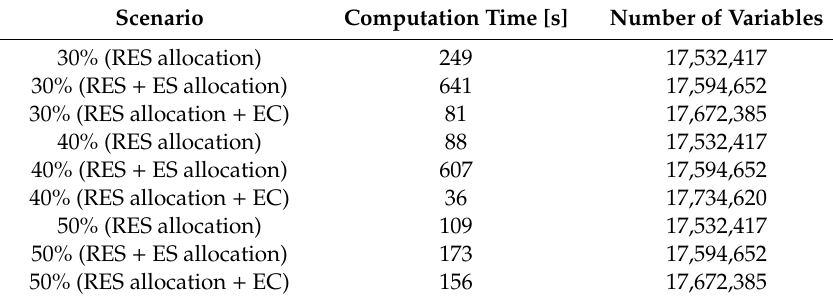
Table 4. Computation time and number of